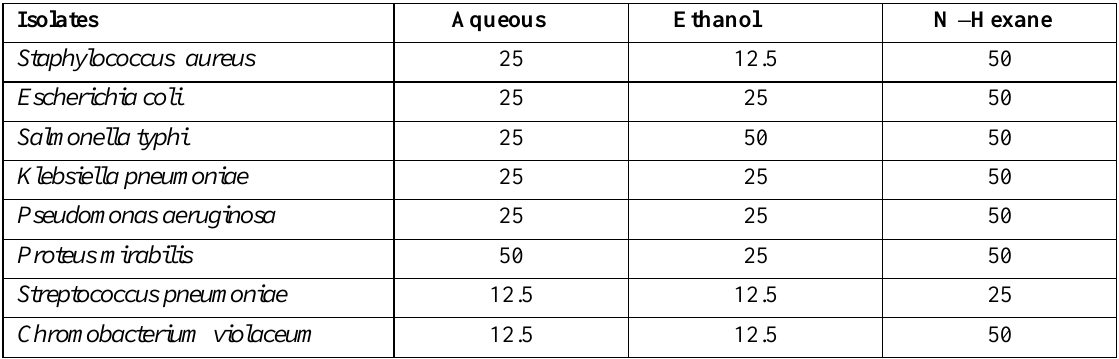
Table 5. Minimum inhibitory concentration (MIC) (mg/ml), of leaf extracts of Citrus aurantium on Bacterial Isolated from hepatitis B surface antigen positive individuals.